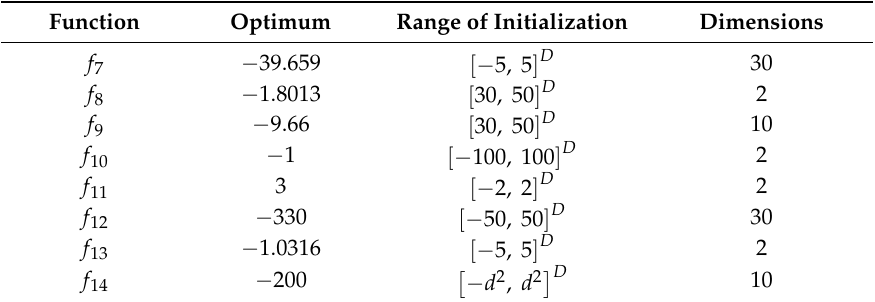
Table 7. Shift Index (SI) and Shift Value (SV) [27].